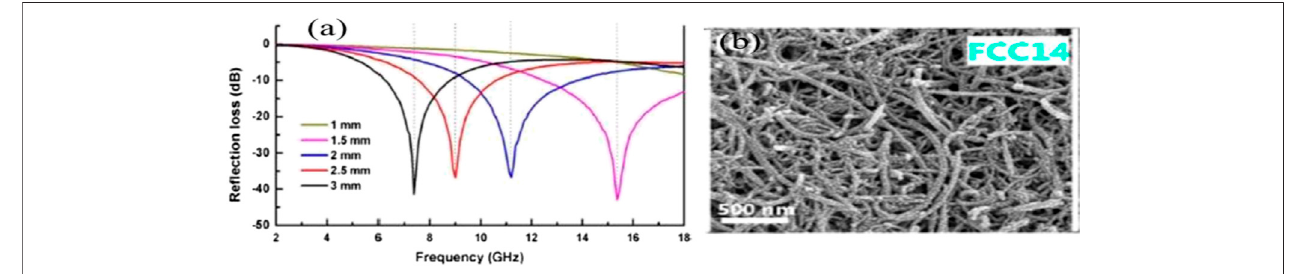
FIGURE 3 | (A) Re fl ection values of FCC14 with different thicknesses. (B) SEM images of (FCC14) CNT to Fe 3 + (1:4) (Li et al., 2017).